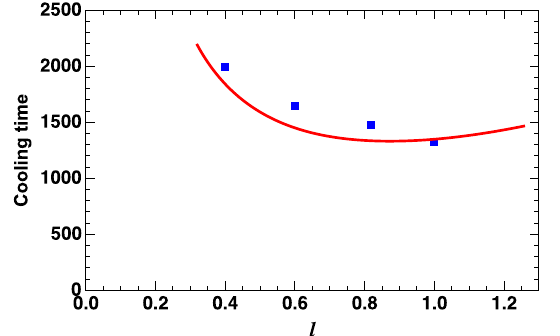
FIG. 12. Cooling time as a function of dimensionless length l of the amplification section for one